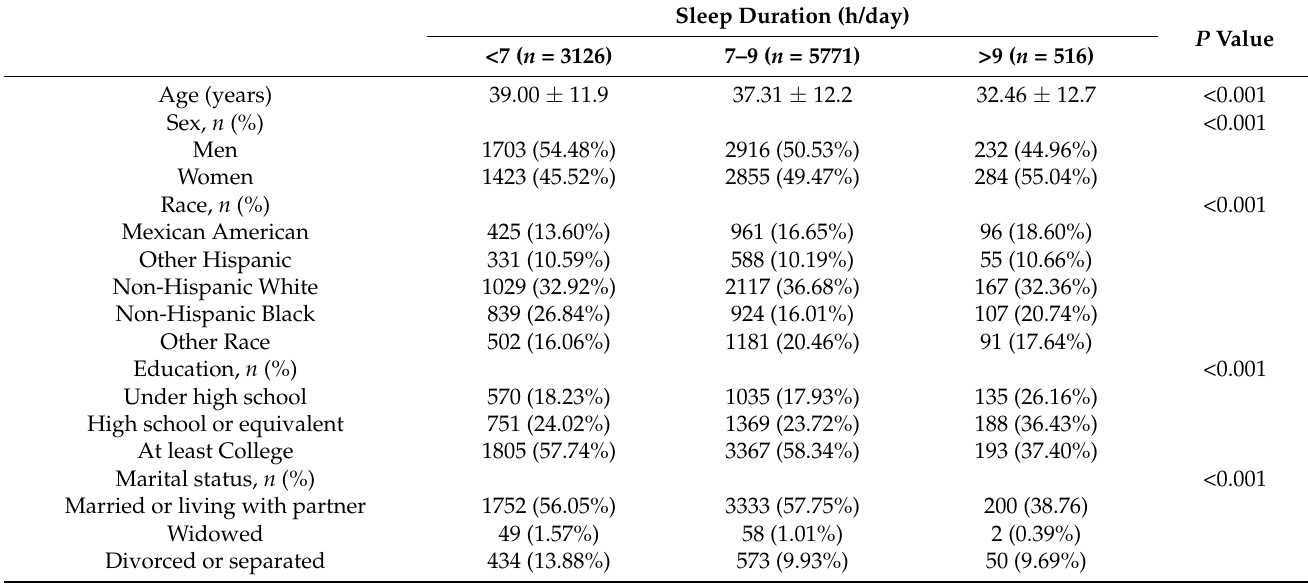
Table 1. Characteristics of participants grouped by short, normal, and long sleep